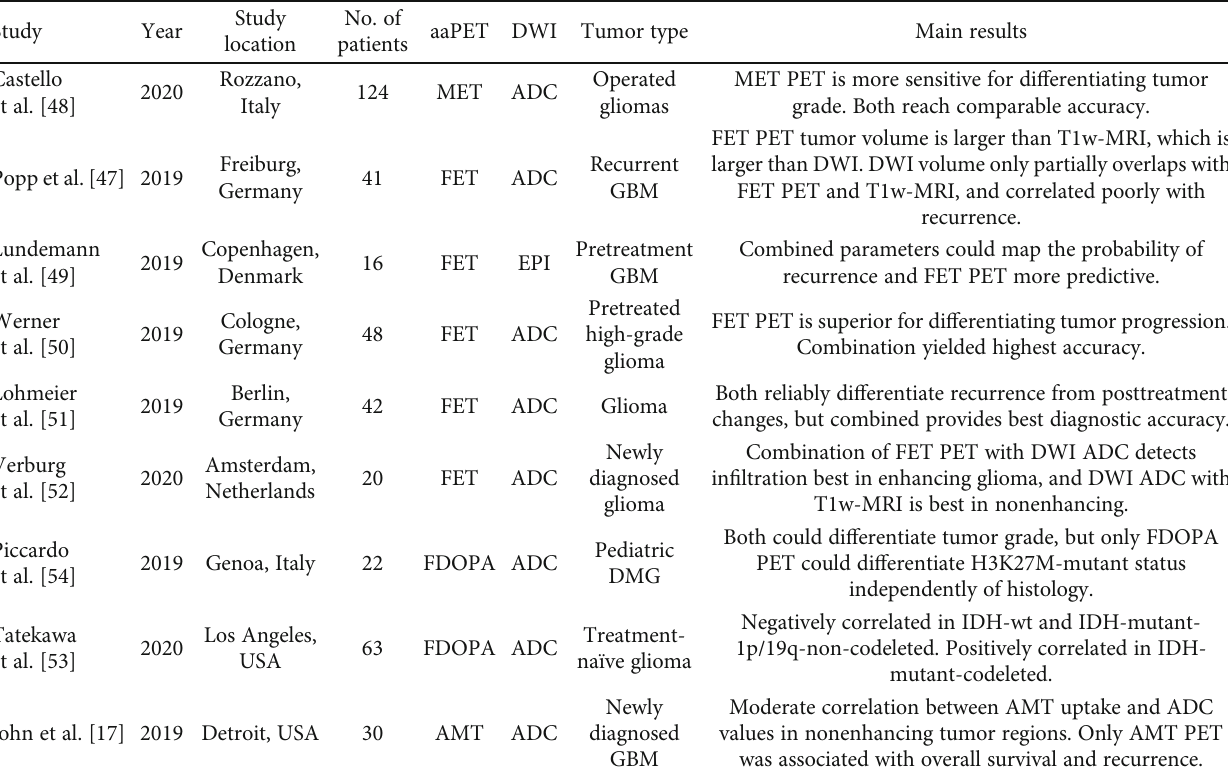
Table 1: Summary of aaPET with DWI